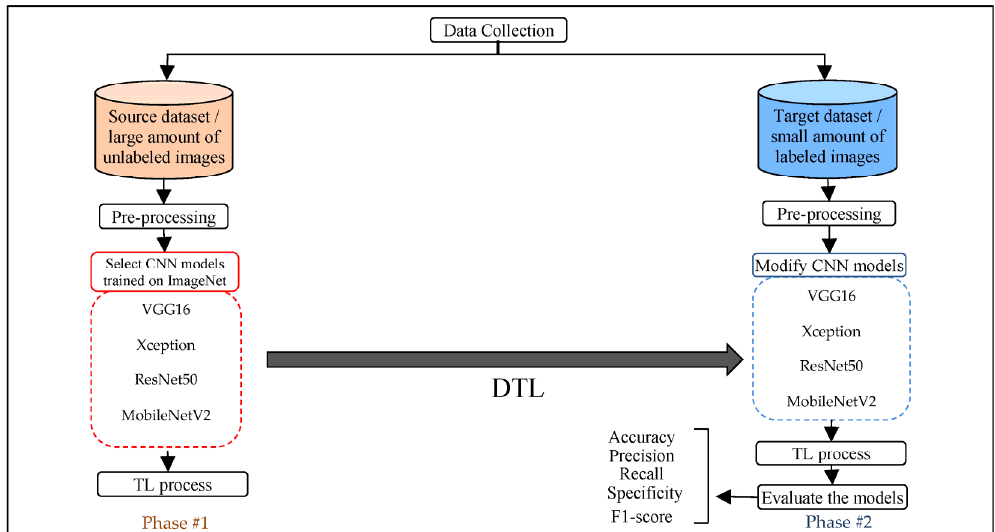
Figure 3. Steps and general framework for the proposed